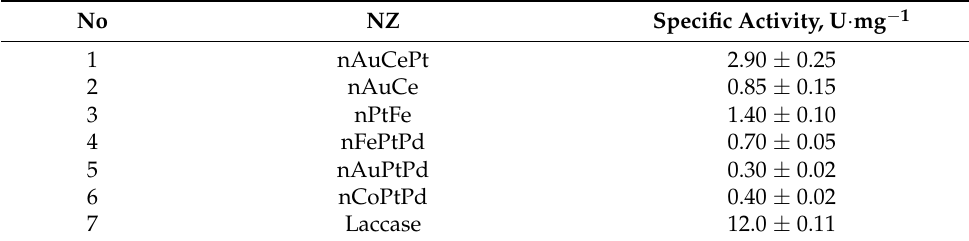
Table 1. Laccase-like activities of the synthesized NZs in